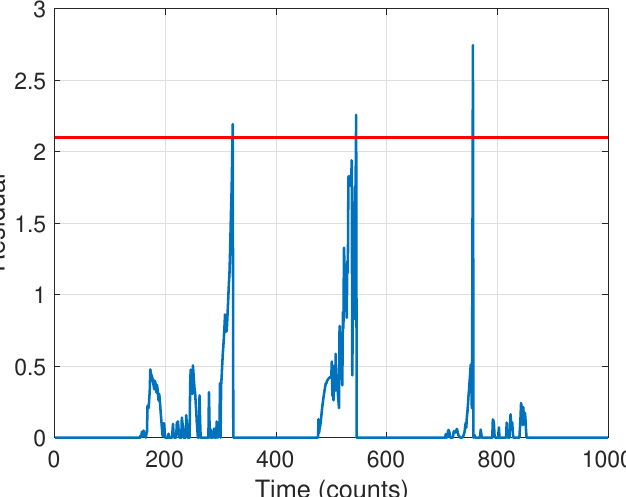
Figure 11. Residual signal for change detection. The selected threshold is indicated with a red dashed